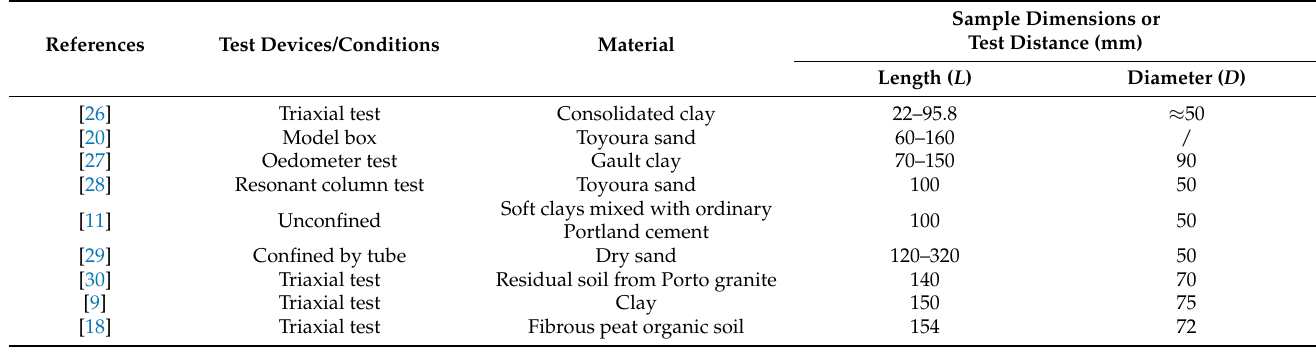
Table 1. Sample length and test devices/conditions in some selected